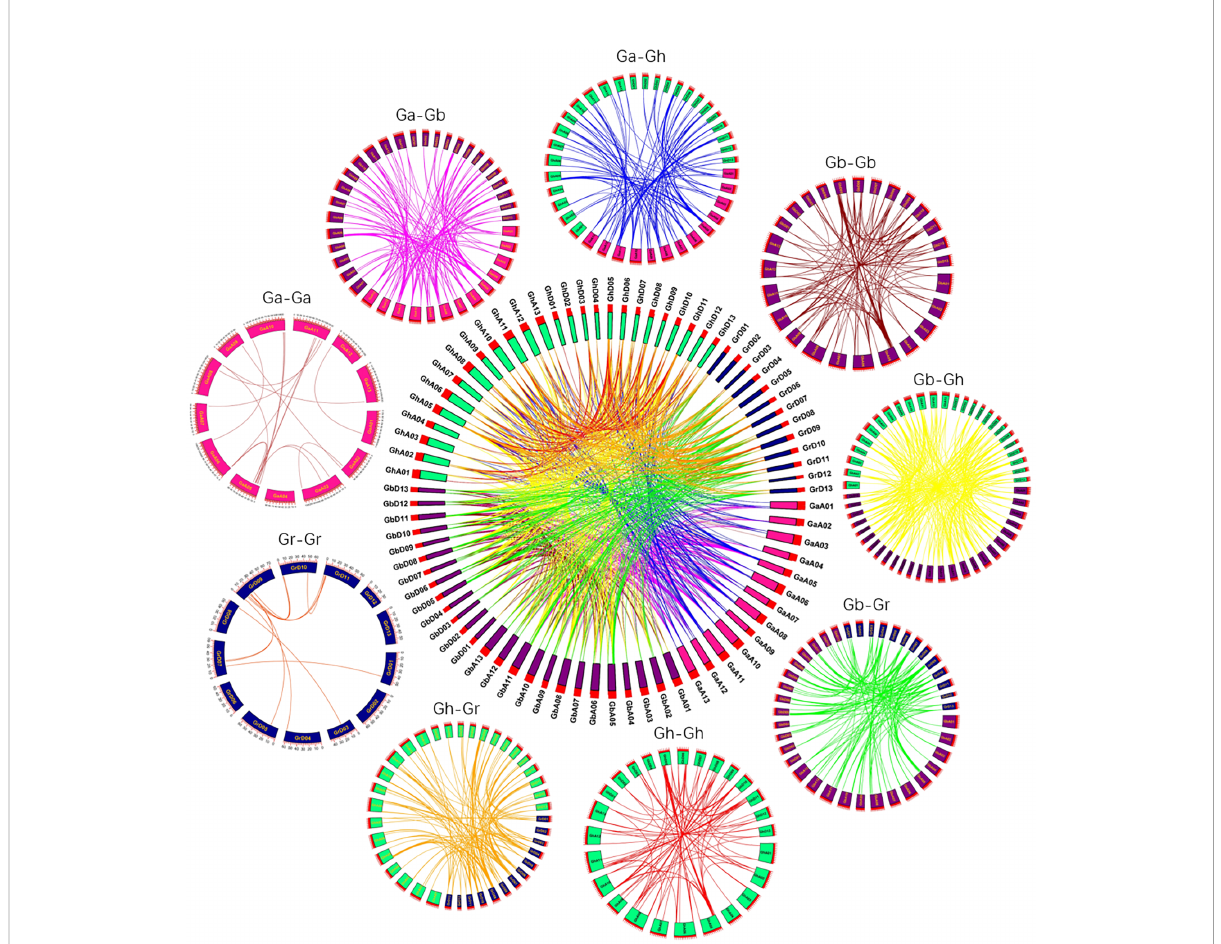
FIGURE 5 Collinearity of repeated gene pairs in four cotton specie s ( Gossypium hirsutum, Gossypium barbadense, Gossypium arboreum and Gossypium raimondii ). The collinearity region around the SBT gene is indicated by chromosomal lines of different